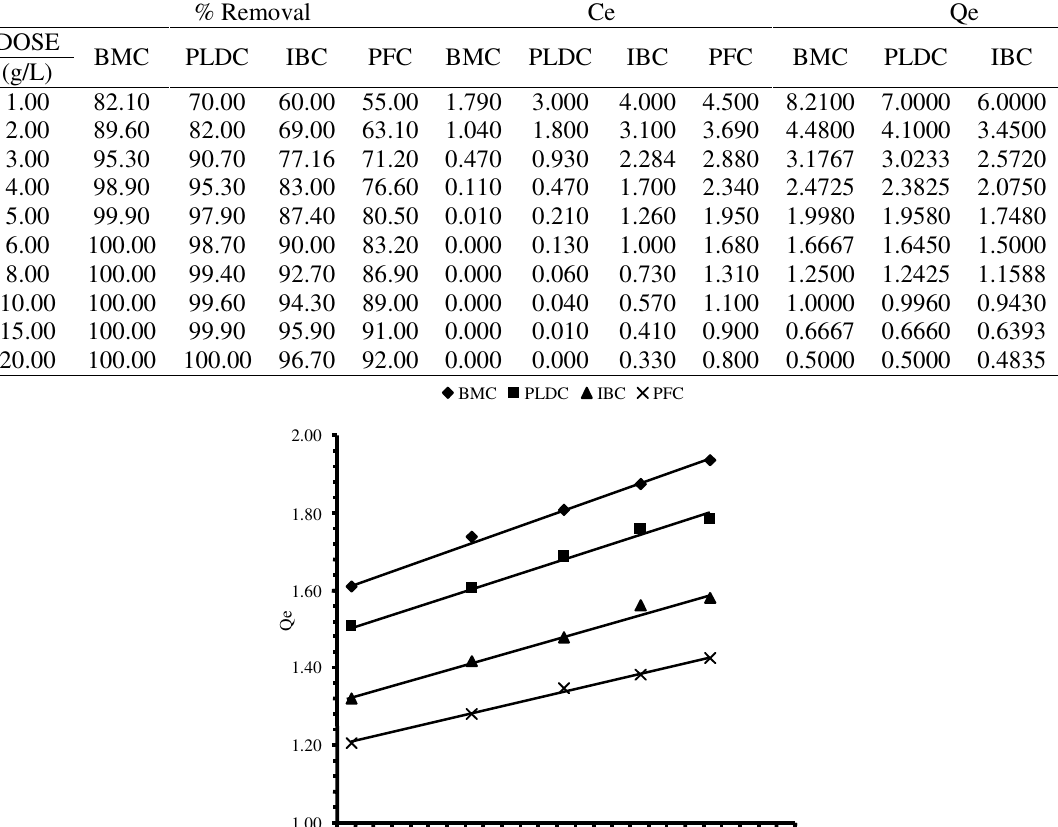
Table 5. Effect of dose on the percent removal of Mn(II) by adsorption with prepared ACs.